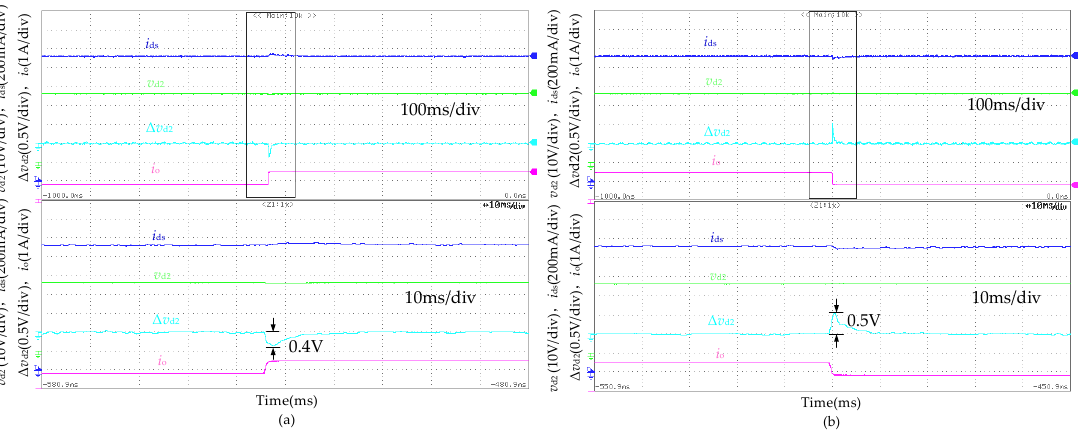
Figure 9 . The experimental results of i ds , v d2 , Δ v d2 and i o with LADRC method, ω n = 2887 rad/s and r v Figure 9. The experimental results of i ds , v d2 , ∆ v d2 and i o with LADRC method, ω n = 2887 rad/s and = 0.2 Ω: ( a ) sudden load increase; ( b ) sudden load decrease. r v = 0.2 Ω : ( a ) sudden load increase; ( b ) sudden load